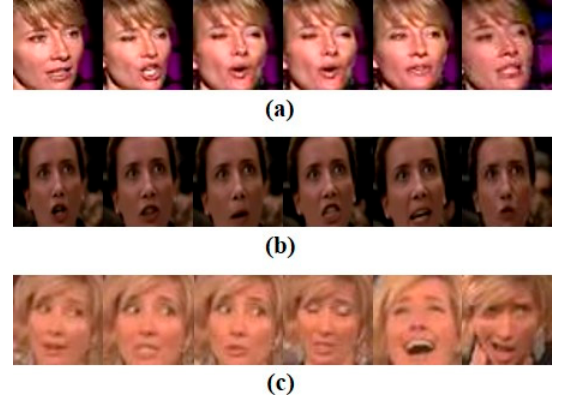
Figure 2. Samples from YCT. ( a – c ) Three unique long videos of one individual in the YTC database [51].